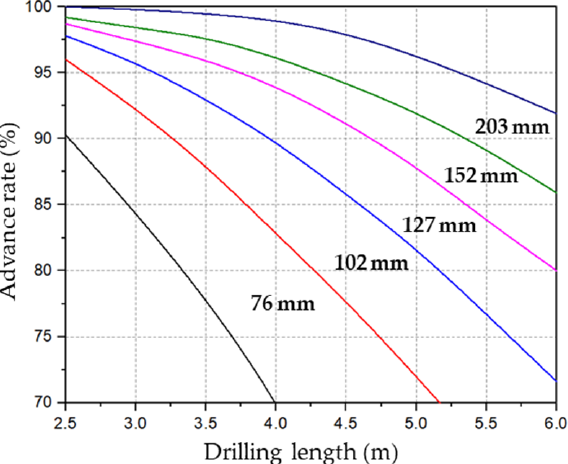
Figure 5. Comparison of advance rates according to the length and diameter of empty holes.